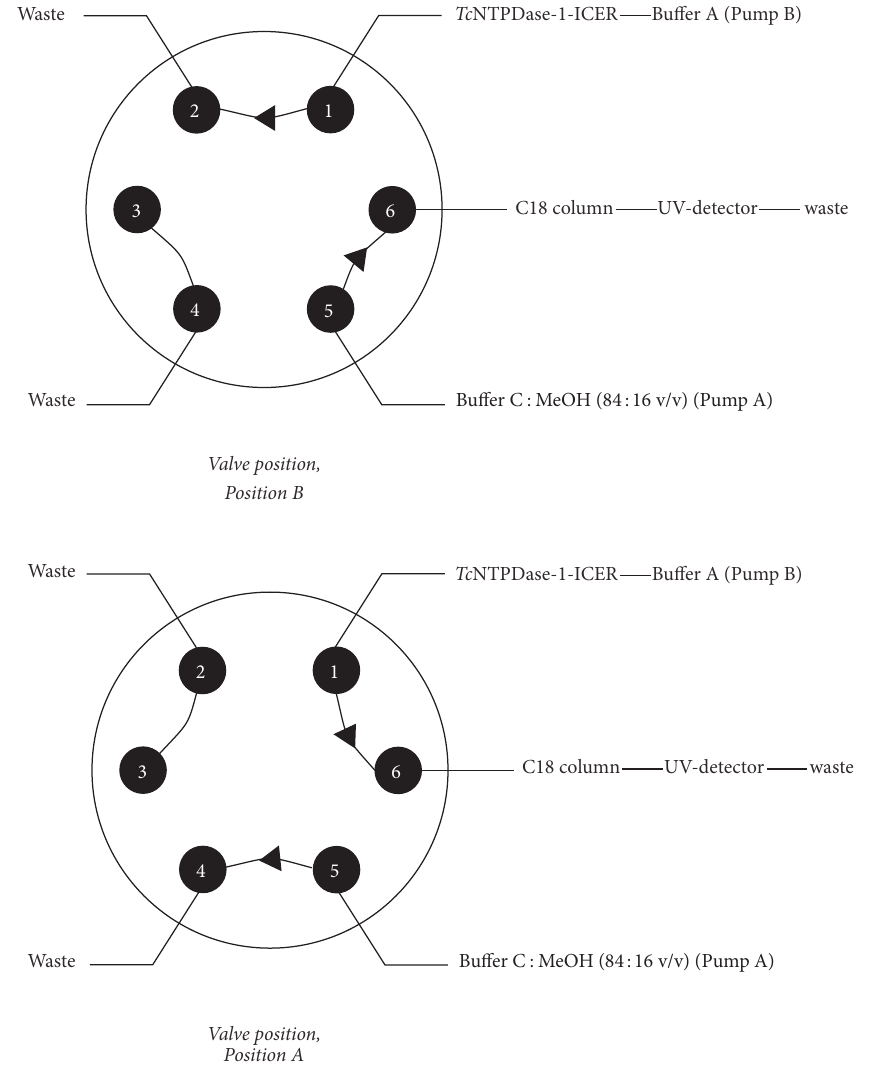
Figure 2: Schematic diagram of the two-dimensional system and the switch valve positions. Position B: column conditioning; Position A: coupled columns. In the chromatographic conditions optimized for the two-dimensional system (Figure 1), Phenomenex Luna C18 (100 ˚A 250 × 4.6 mm, 5 𝜇 m) analytical column conditioned with Buffer C: MeOH (84 :16 v/v) at a flow rate of 1.0 mL ⋅ min −1 and UV detection at 𝜆 =